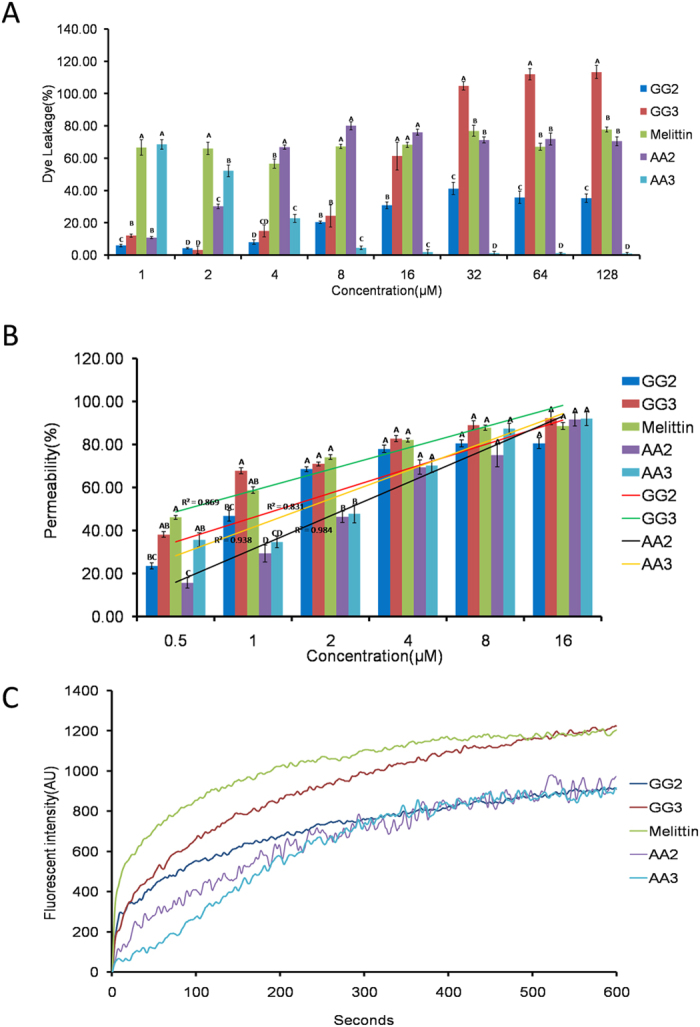
(A) Percent leakage of the dye calcein from negatively charged POPC/POPG (3:1) LUVs in the presence of the centrosymmetric peptides. (B) The outer membrane permeability of the centrosymmetric peptides, as determined using the fluorescent dye (NPN) assay. (C) The cytoplasmic membrane potential variation of E. coli UB1005 treated by 1 × MBC centrosymmetric peptides, as assessed by release of the membrane potential-sensitive dye diSC3-5. The graphs were derived from average values of three independent trials. Means in the same concentration with different superscript are very significant difference (P < 0.01).